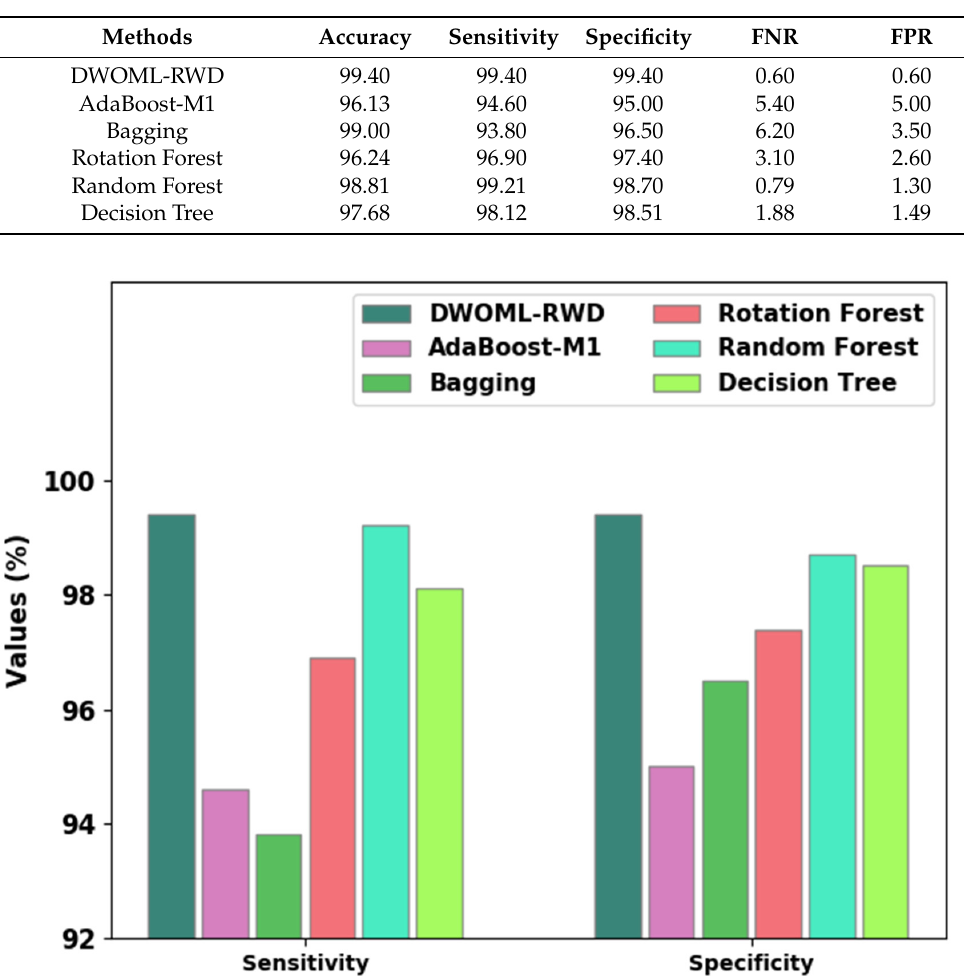
Table 3. Comparative analysis of DWOML-RWD technique with existing algorithms.